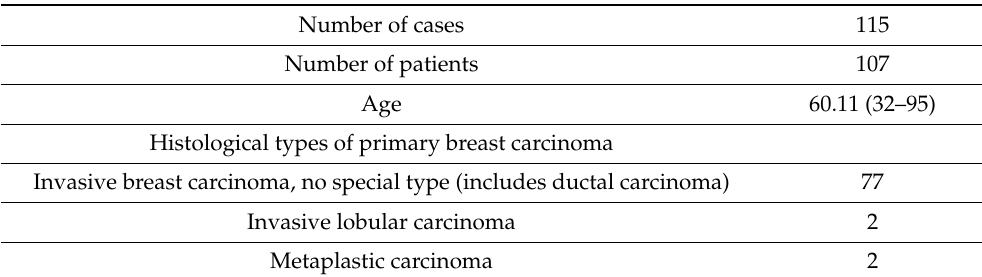
Table 1. Demographics of the